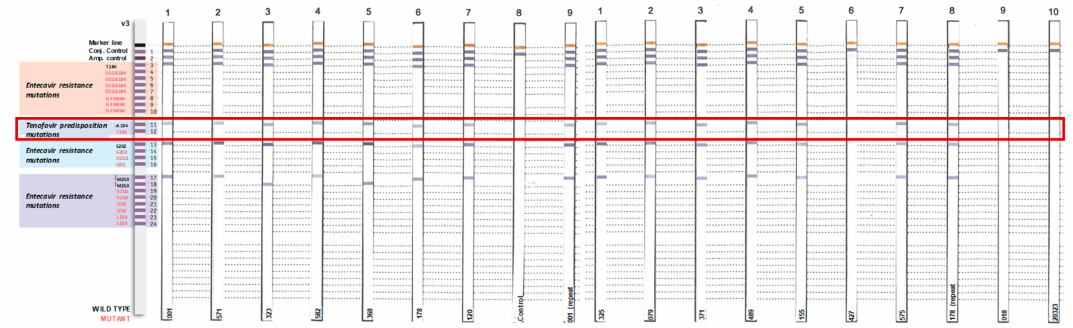
Figure 4. No tenofovir-related mutations were detected among HIV-infected women from the CAPRISA 004 trial with the INNO-LiPA HBV DR v3